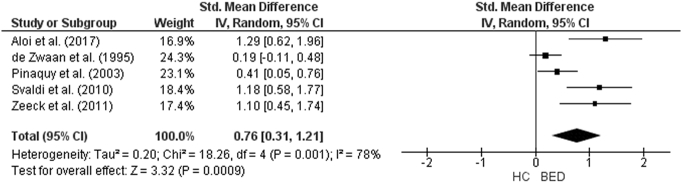
Forest plot of mean TAS score: standardized mean effect size for differences (SMD) between Binge Eating Disorder (BED) and Healthy Controls. CI, confidence interval.